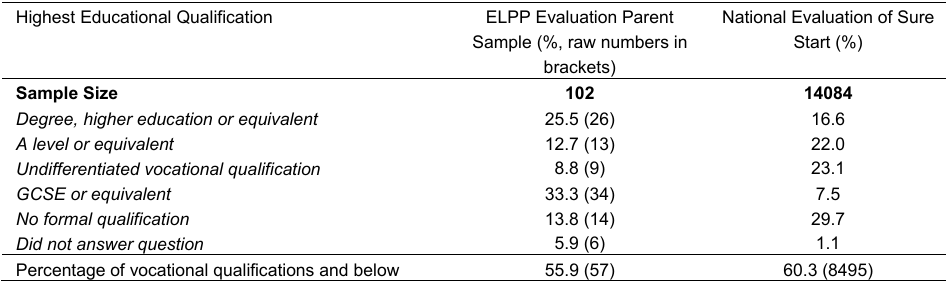
Table 3 : Comparing the ELPP parent sample to NESS: highest educational qualificatio Highest Educational